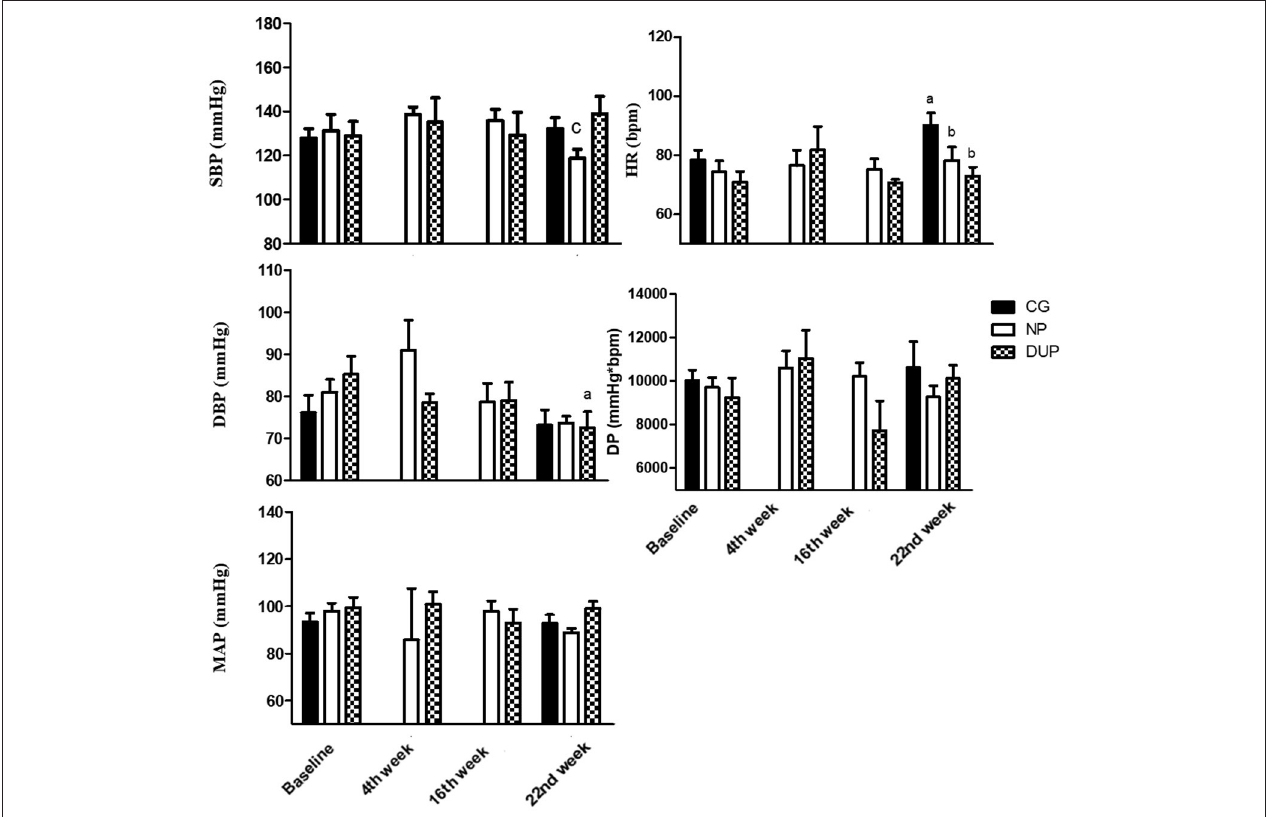
FIGURE 5 | Hemodynamic parameters of experimental groups in the normotensive subsample. Values expressed as mean ± SD.NP, Non-periodized; DUP, Daily undulating periodization; CG, Control group; SBP, Systolic blood pressure; DBP, Diastolic blood pressure; MAP, Mean arterial pressure; HR, Heart rate; DP, Double product; a P < 0.05 vs. Baseline; b P < 0.05 vs. CG in the 22nd week; c P < 0.05 vs. DUP in the 22nd week. An ANOVA [3 × 2, groups × time] was used to examine differences between NP, DUP and CG pre and post-exercise. An ANOVA [2 × 4, groups × time] was used to examine differences between NP and DUP over the 4 measurement moments (Baseline, 4th week, 16th week, and 22nd week). Dunnet was performed as the post-hoc